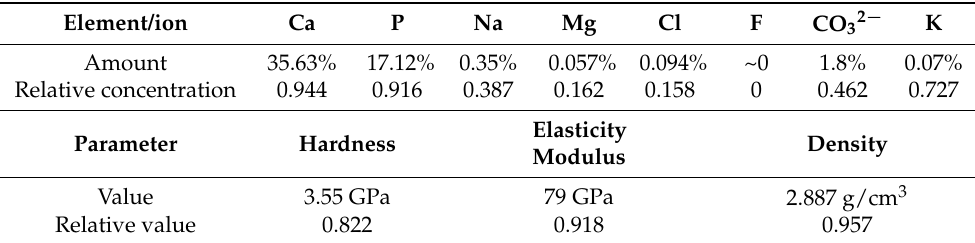
Table 1. Basic chemical values of the enamel core and mechanical